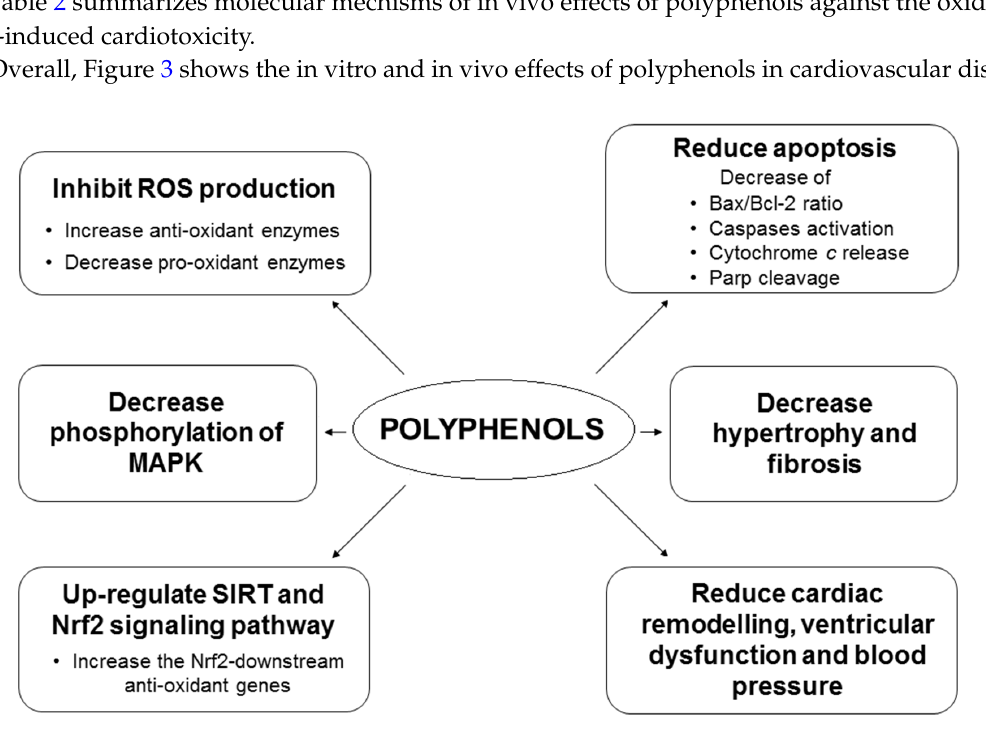
Figure 3. In vitro and in vivo effects of polyphenols in cardiovascular disease.